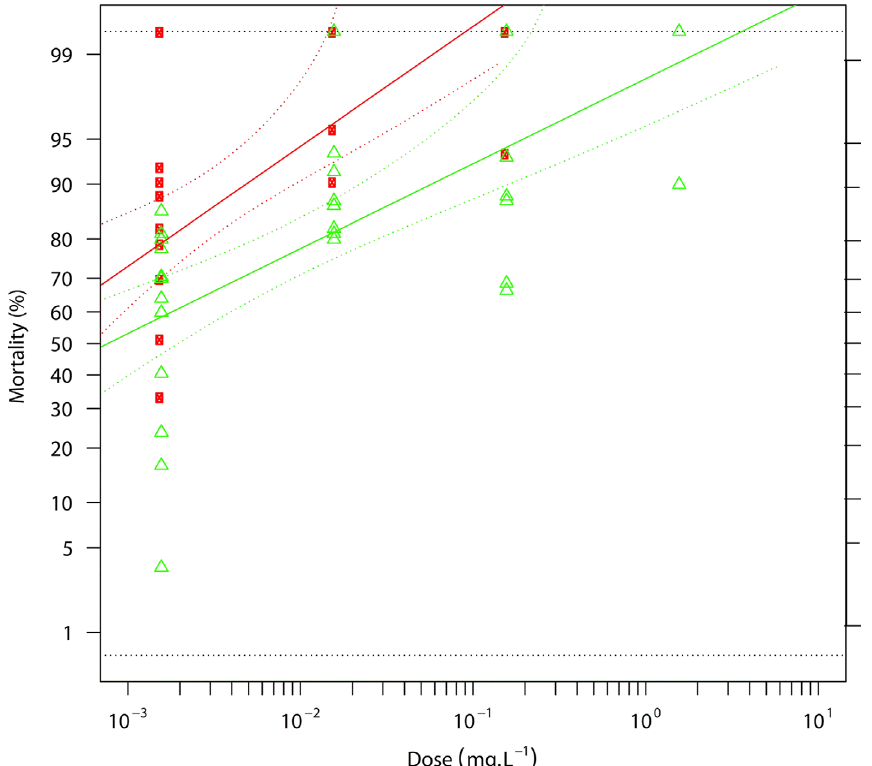
Figure 2. Regression line showing the mortality rates of the Kisumu and M’Bé strains to relative doses of chlorfenapyr. Red squares: Kisumu; green triangles: